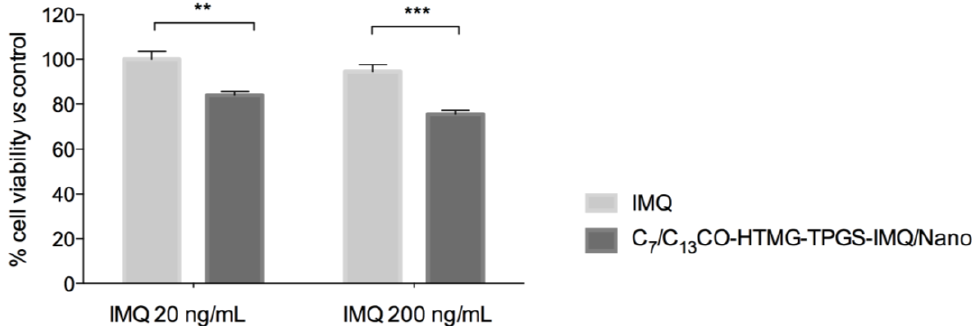
Figure 7. Cytotoxicity of free IMQ and C 7 /C 13 CO-HTMG-TPGS-IMQ/Nano on 501Mel cells. 501Mel cells (4 × 10 3 cells) were seeded in 96-well plates and, after overnight attachment, treated with different concentrations of IMQ or IMQ-loaded C 7 /C 13 CO-HTMG-TPGS/Nano for a further 24 h. Cell viability was determined by the MTS assay. Data are presented as means ± SD of three independent experiments, each performed in triplicate. ** p < 0.01; *** p <